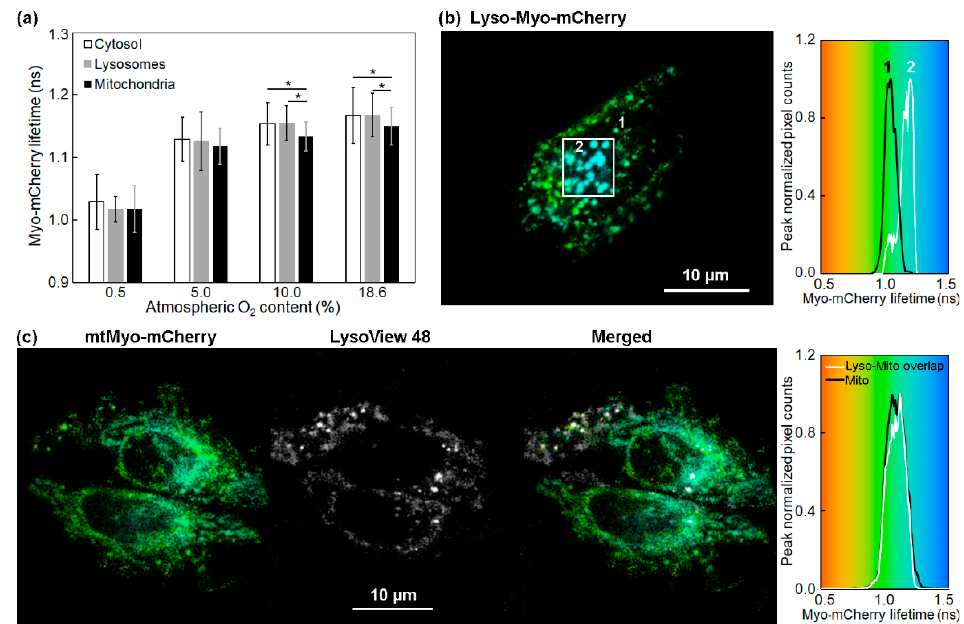
Figure 6. The changes of Myo-mCherry lifetime in HeLa cells using probes targeted to